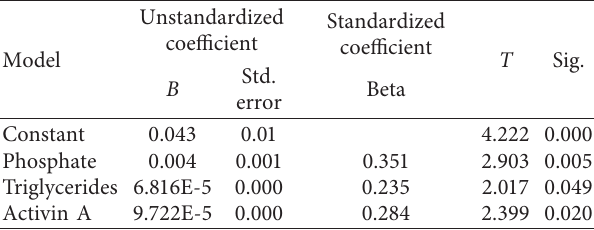
Table 3: Multivariate linear regression